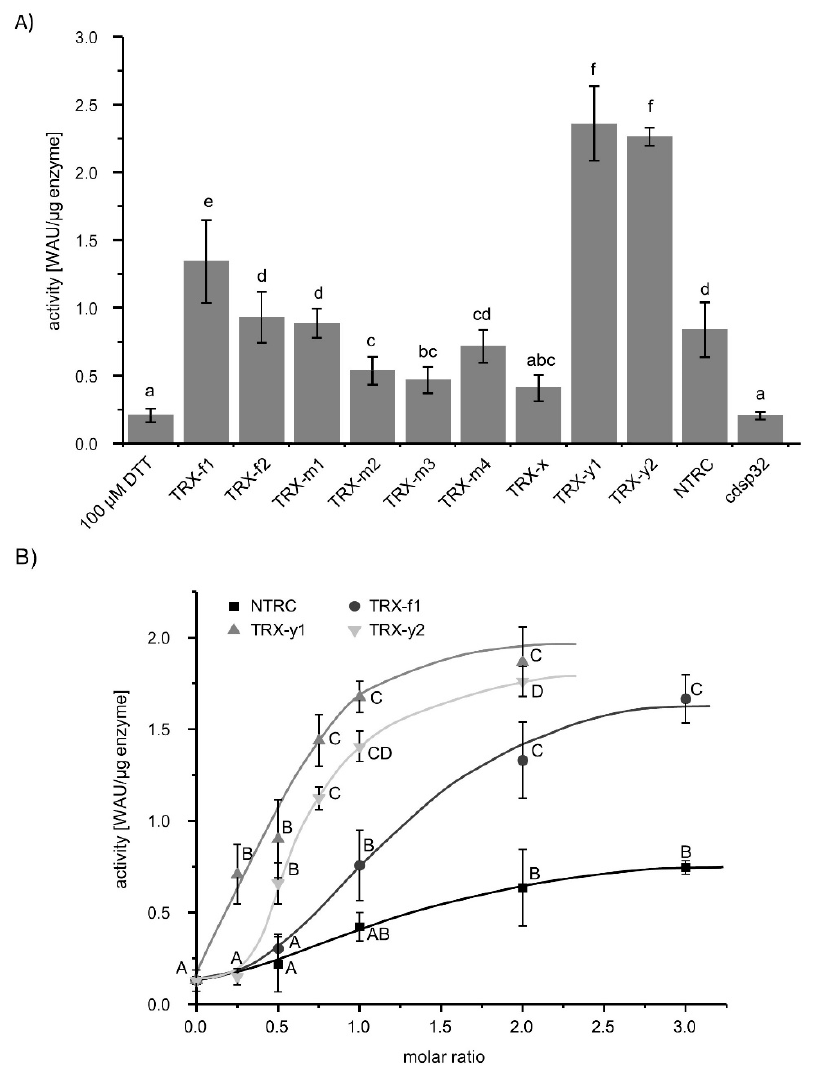
Figure 3. Activation of β CA1 by thioredoxin (TRX). ( A ) Activity of β CA1 after 30 min incubation with 100 µM DTT with or without equimolar amounts of different chloroplast TRXs. Data represent the mean of n ≥ 10 ± SD from two independent protein purifications. Letters a-g indicate significant differences of p ≤ 0.05 calculated with one-way ANOVA and post hoc Tukey HSD. ( B ) Concentration dependent influence of TRX-f1, TRX-y1, TRX-y2, and NTRC on the activity of β CA1. β CA1 was incubated with 100 µM DTT and the indicated molar ratio of the TRXs for 30 min and then subjected to the activity measurement. The values represent the mean of n ≥ 8 ± SD from two independent protein purifications. The letters A-D indicate significant differences of p ≤ 0.05 within each TRX-dependent activity measurement of β CA1. Calculation was done with one-way ANOVA with post hoc Tukey HSD test.